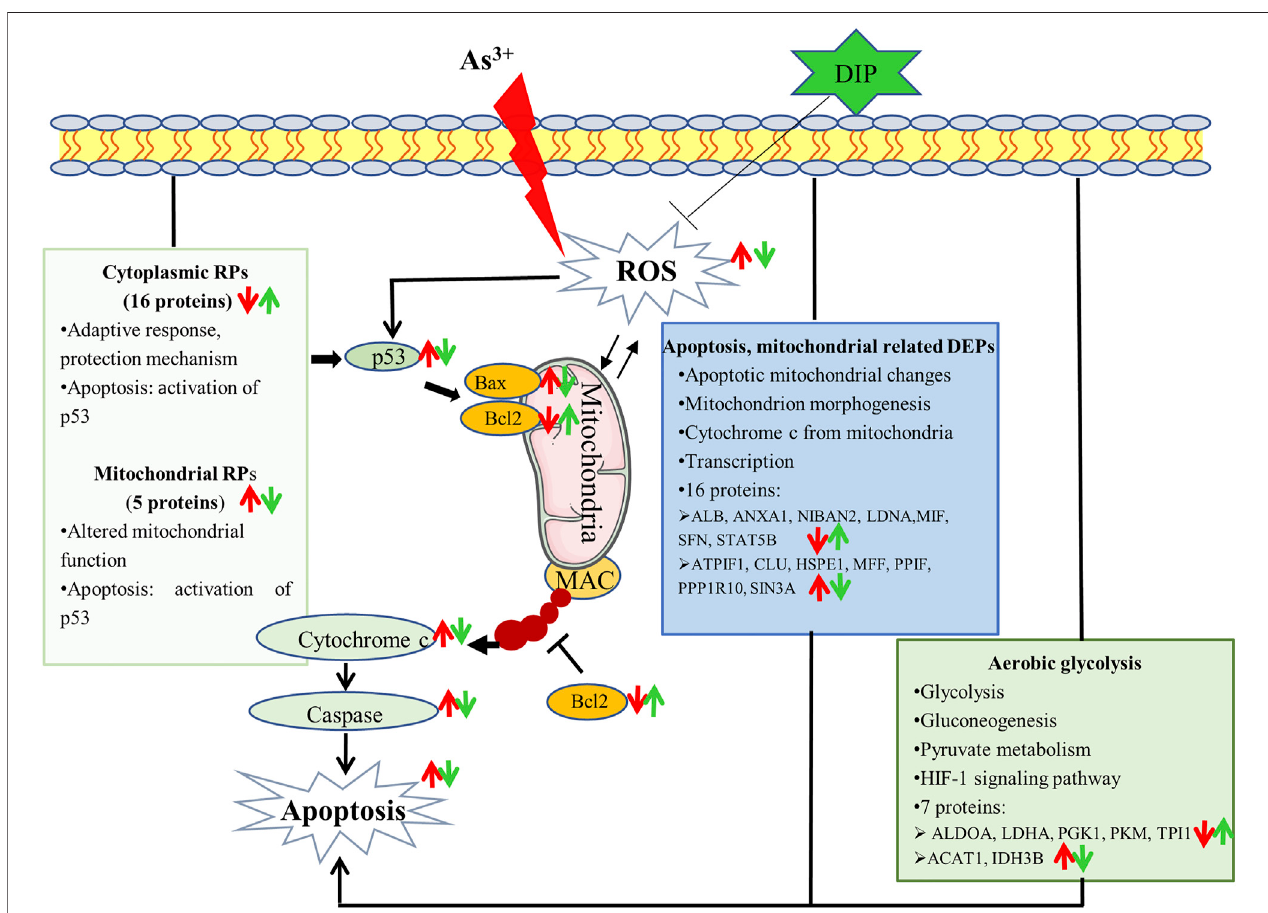
FIGURE 6 | Potential mechanism that sodium arsenite-induced L-02 cell apoptosis and DIP attenuates sodium arsenite-induced apoptosis.: ↑ up-regulation.: ↓ down-regulation. Red is related to As 3+ , green is related to DIP.